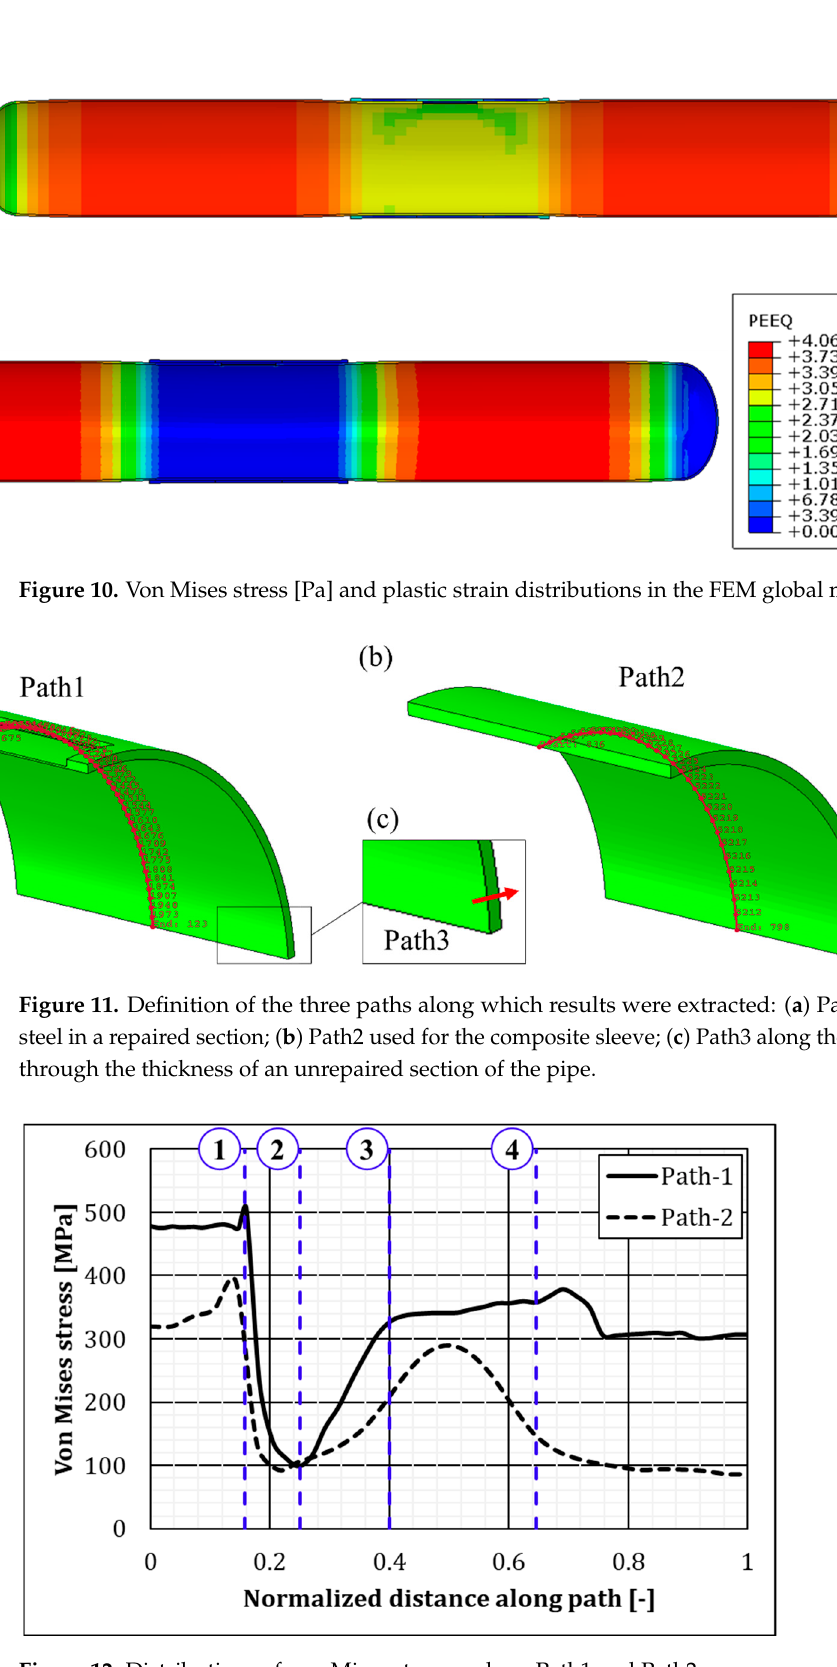
Figure 13. Radial displacement [m] on the deformed shape (magnification 5×) of the pipe section in the damaged part; highlights of the geometric Points considered in Figure 12.